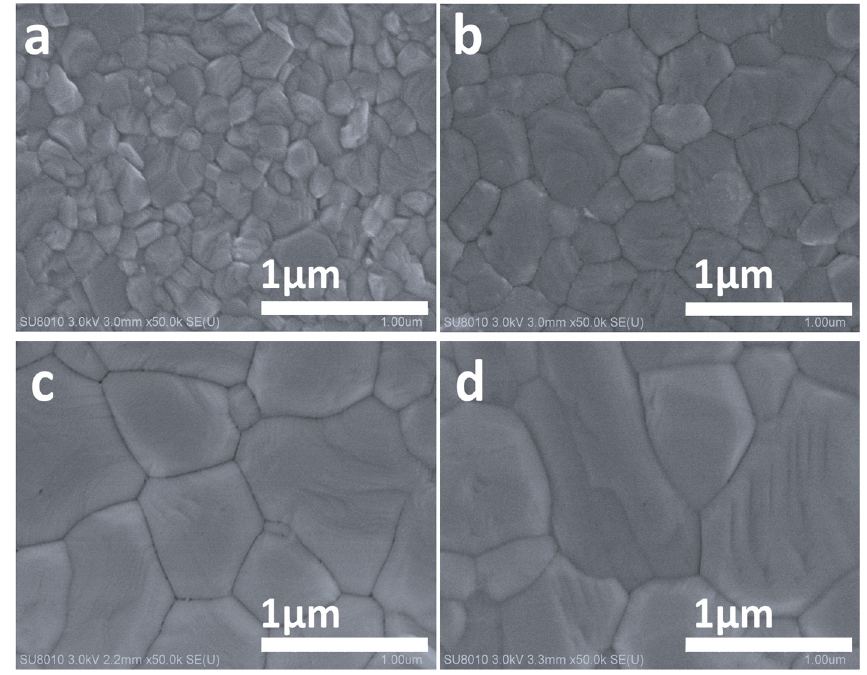
Figure 2. Top view of SEM images for ( a ) control, ( b ) DABr-1.5, ( c ) DABr-2.5 and ( d ) DABr-3.5-treated 2D-3D perovskite films.